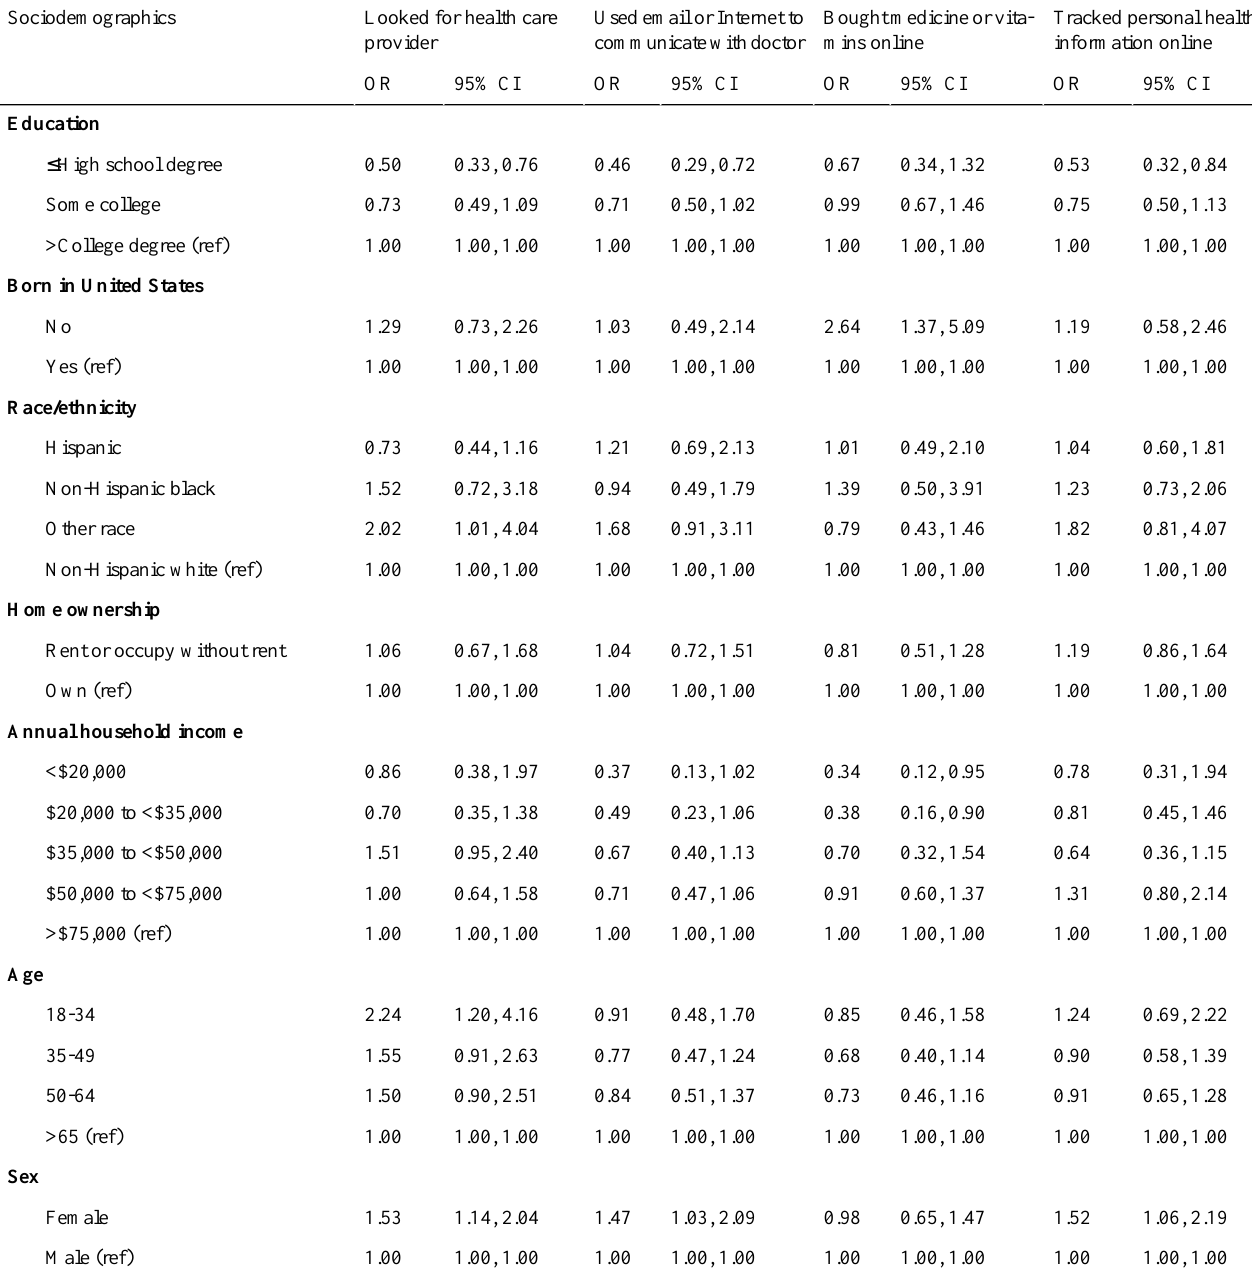
Table 3. Multivariable logistic regression models for odds a of reporting yes to eHealth usage by socioeconomic status and race/ethnicity, Health Information National Trends Survey (HINTS),